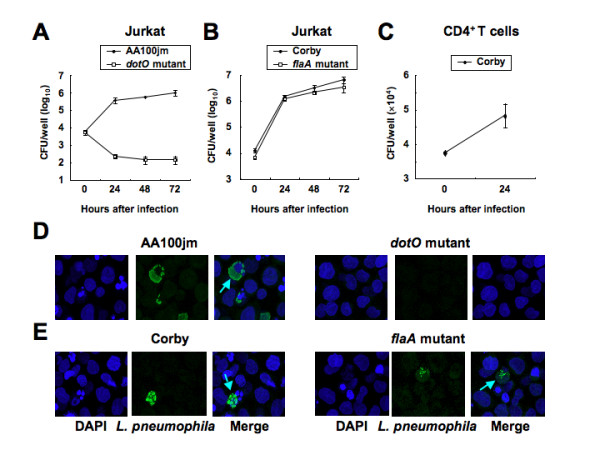
Intracellular growth of L. pneumophila strains in Jurkat cells and CD4+ T cells. Jurkat cells were infected with L. pneumophila strains AA100jm and dotO mutant (MOI of 100) (A) or Corby and flaA mutant (MOI of 100) (B). (C) CD4+ T cells were also infected with Corby (MOI of 50). At the indicated time points after infection, the CFU was enumerated. Data are mean ± SD of triplicate cell cultures. (D and E) Direct fluorescent antibody staining of L. pneumophila strains. Jurkat cells were infected with AA100jm and dotO mutant (MOI of 100) (D) or Corby and flaA mutant (MOI of 100) (E) for 24 h. Jurkat cells were stained with fluorescein-conjugated anti-L. pneumophila antibody. Original magnification, ×600.